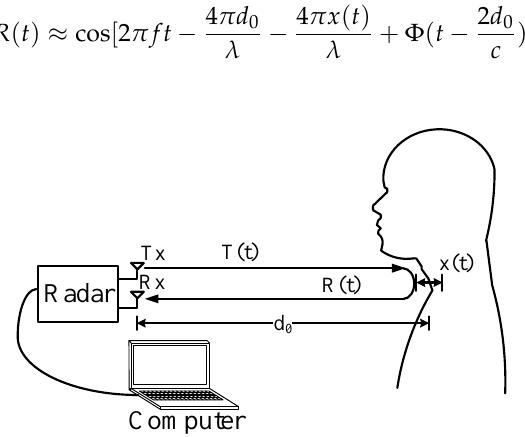
Figure 2. Mechanism of auditory radar